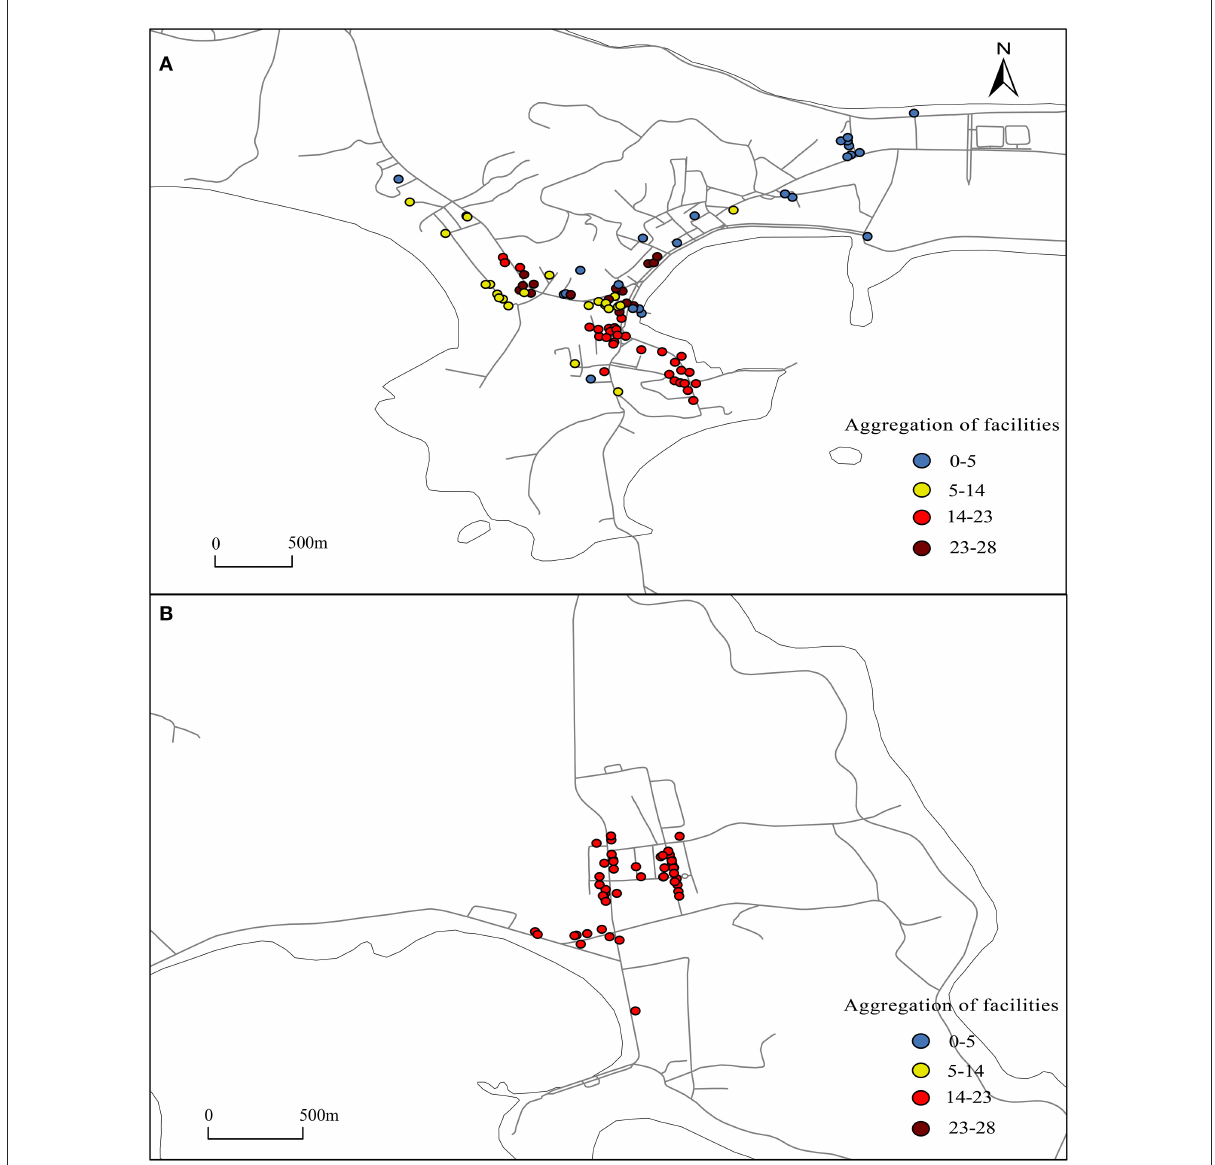
FIGURE3 Facility agglomeration in the study area. (A, B) Setting both catering and shopping facilities as the starting and ending points, import the road data, and calculate the number of facilities that can be reached from other facilities within 800 meters. The greater the number of accessible facilities is, the higher the concentration of